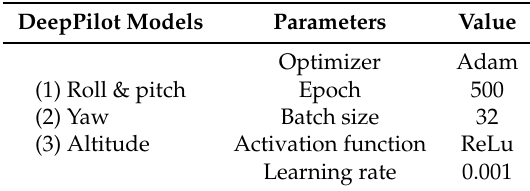
Figure 3. DeepPilot Architecture: our proposed DeepPilot runs 3 specialized models in parallel. The first one predicts φ and θ angular positions of the body frame; the second one predicts ψ , the rotational speed over the Z-axis; and the third one predicts h , the vertical speed. The size of the kernels is indicated in the colored boxes at the bottom-left. Table 1. Parameters used to train 3 specialized models in our DeepPilot approach to learn the flight commands represented by the variables roll and pitch ( φ , θ ), yaw ( ψ ), and altitude ( h